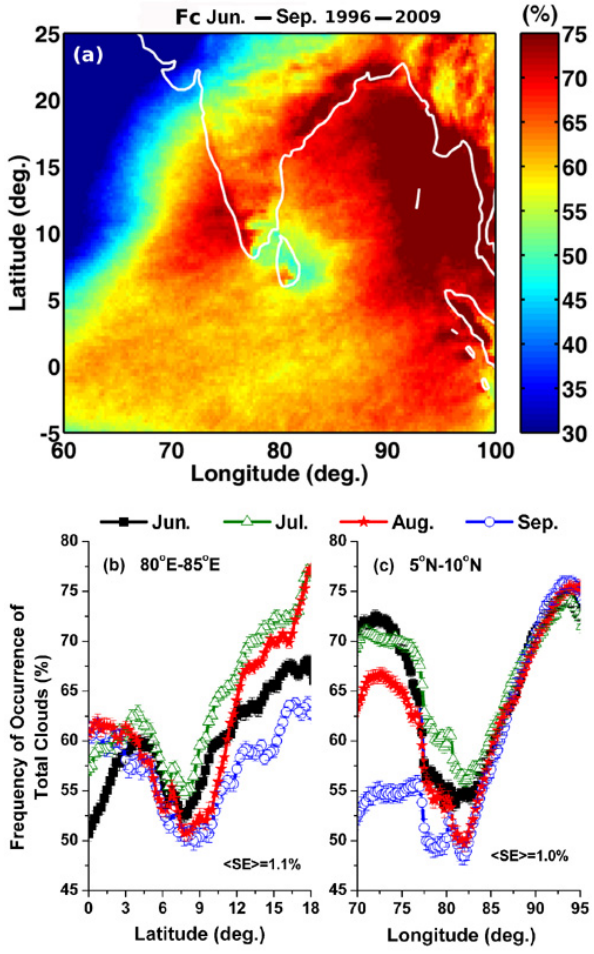
Fig. 1. (a) Long-term (1996–2009) seasonal mean spatial distri- bution of the frequency of occurrence of clouds ( F c , expressed in percentage) observed during ASM. (b) Long-term monthly mean latitudinal variations of the frequency of occurrence of clouds, av- eraged along in 80–85 ◦ E during June, July, August and September. (c) Same as (b) but for the longitudinal variation averaged along 5–10 ◦ N. The vertical lines indicate the standard errors of F c and < SE > represents average